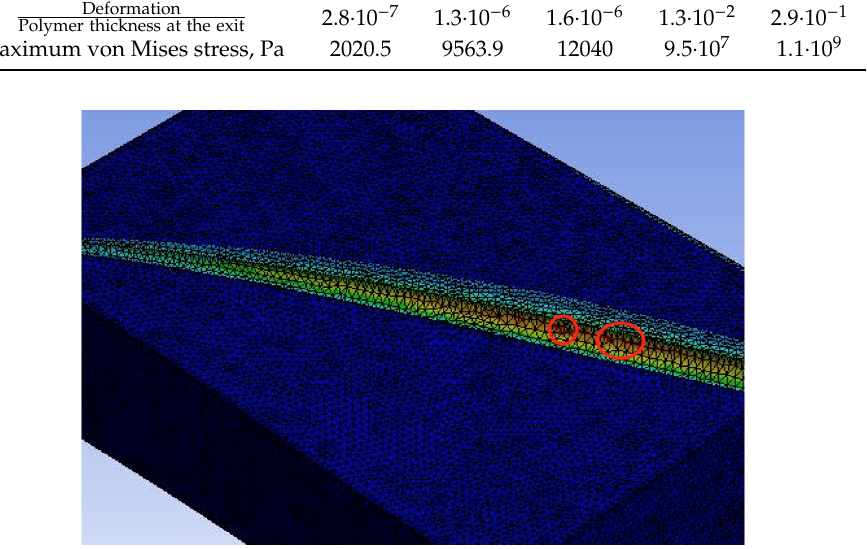
Figure 10. High stress elements: material #3.